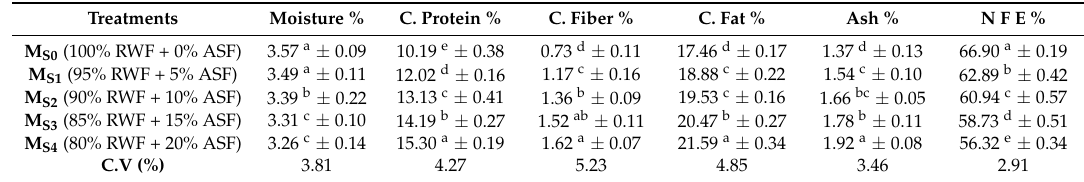
Table 4. Proximate composition of control and supplemented